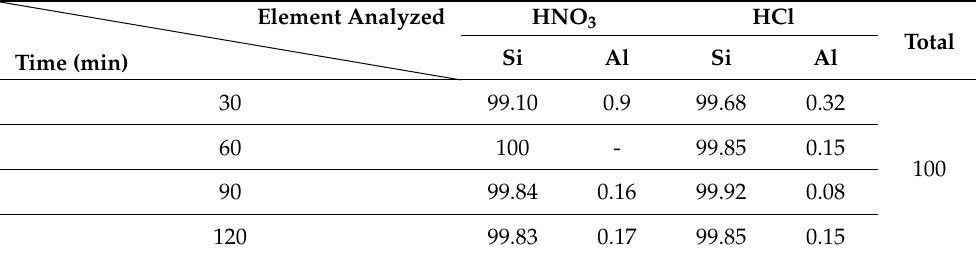
Table 7. XRF analysis results of a photovoltaic cell after drying — time (unit: wt.%). Element Analyzed Time